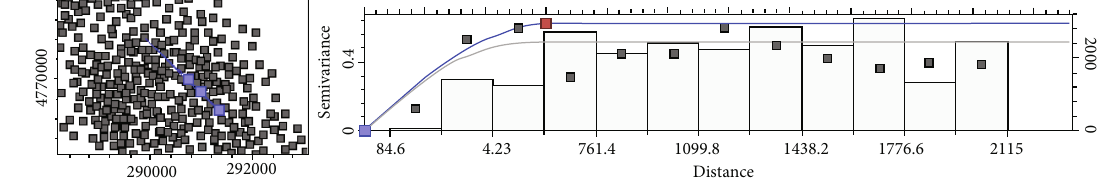
Figure 8: Normalization and matching in variogram Table 4: Wetting angle and interfacial tension value [34, 35].